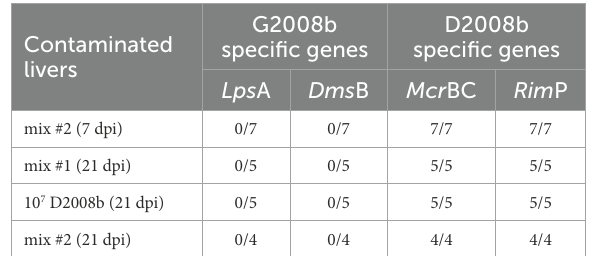
TABLE 3 Total Campylobacter jejuni counts in liver (CFU/g of liver) from birds at 1 dpi, 7 dpi and 21 dpi for rooms 1 and 2.